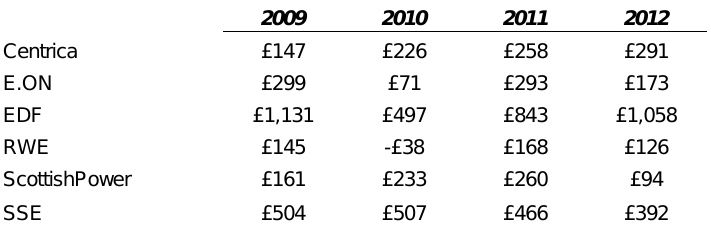
Figure 52: Six largest suppliers’ Generation EBIT